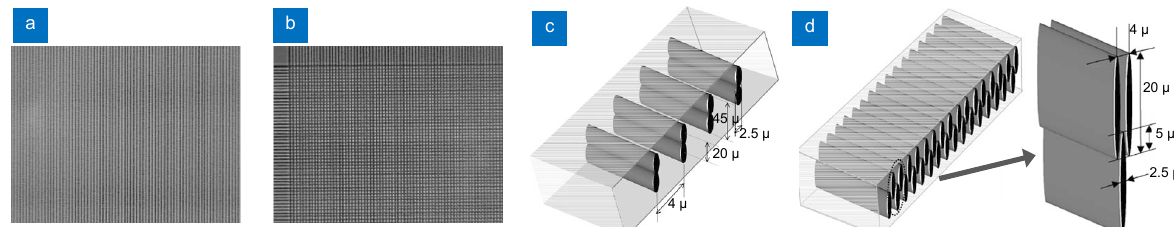
Fig. 11 | ( a ) Internal diffraction 1D micro-grating fabricated with fs laser. ( b ) Internal diffraction 2D micro-grating fabricated with fs laser. Schemes for ( c ) a double-layer 1D micro-grating, and ( d ) a stitched double-layer grating. Figure reprinted with permission from ref. 74 , Springer-Verlag. a